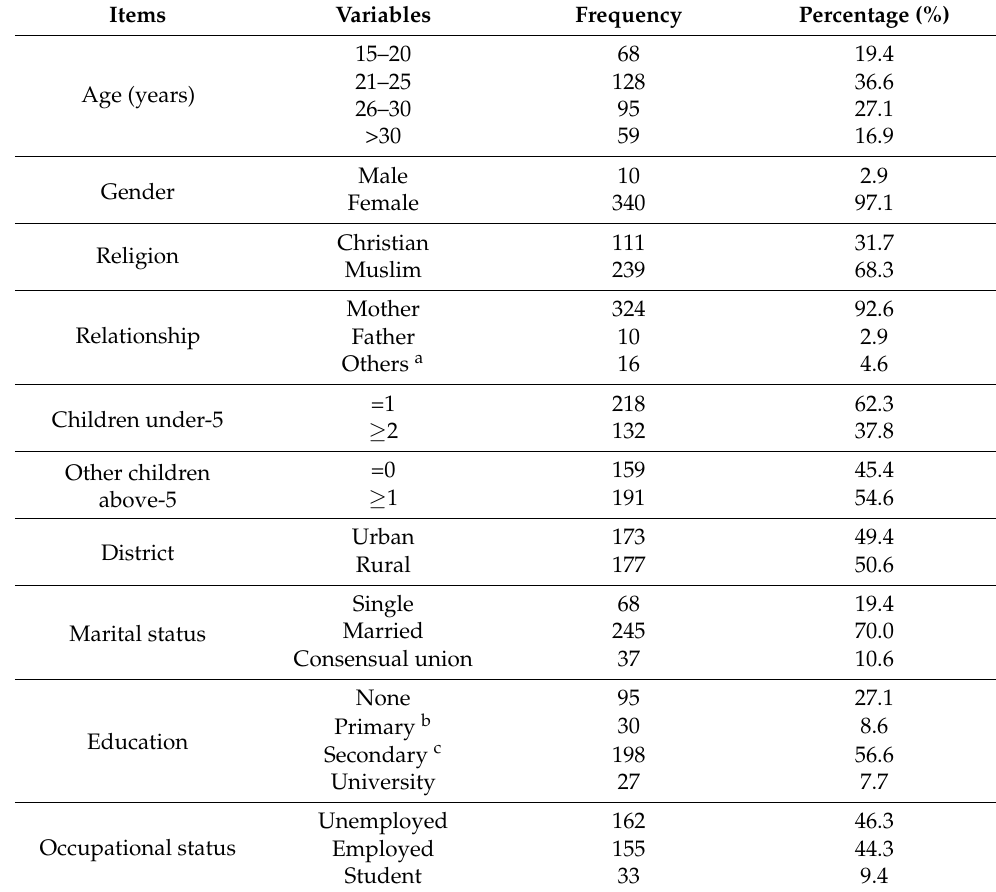
Table 1. Socio-demographics of caregivers of children under-5 ( n =